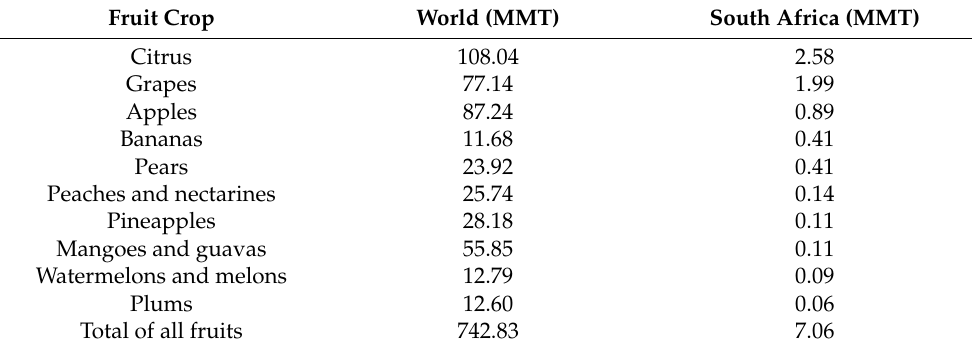
Table 1. Fruit production (million metric ton) in 2019